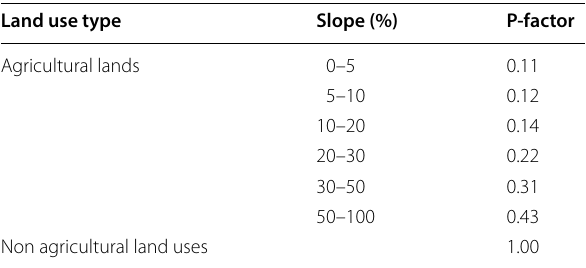
Table 5 P-values modified from Wischmeier and